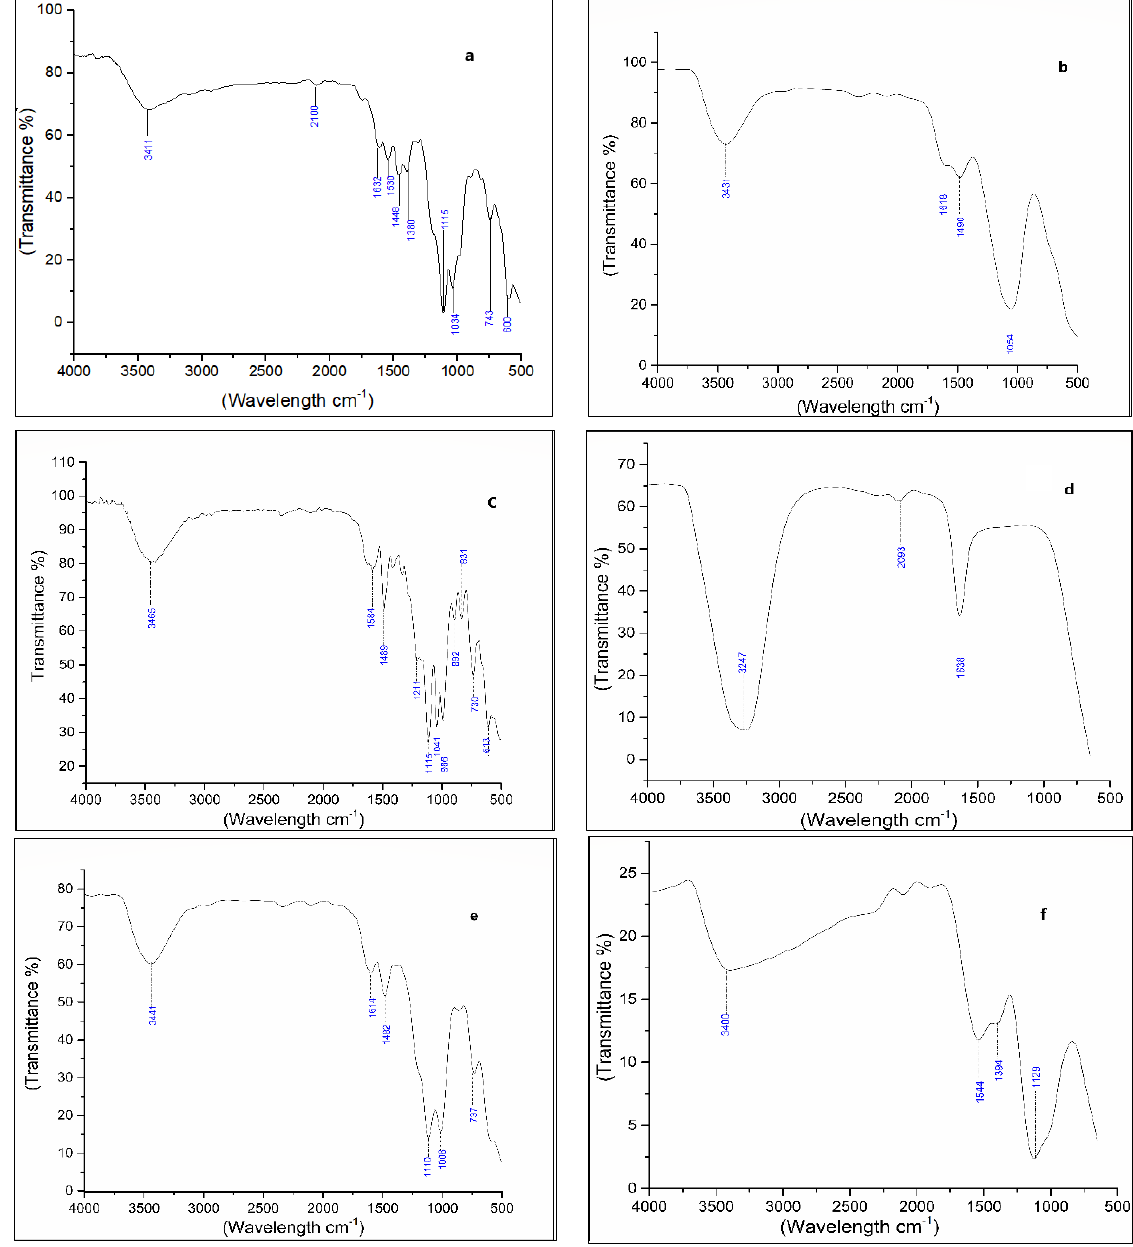
Figure 7. FTIR spectra of ( a ) RR2 control dye, ( b ) RR2 treated dye, ( c ) RB5 control dye, ( d ) RB5 treated dye, ( e ) LY control dye and ( f ) LY treated dye.